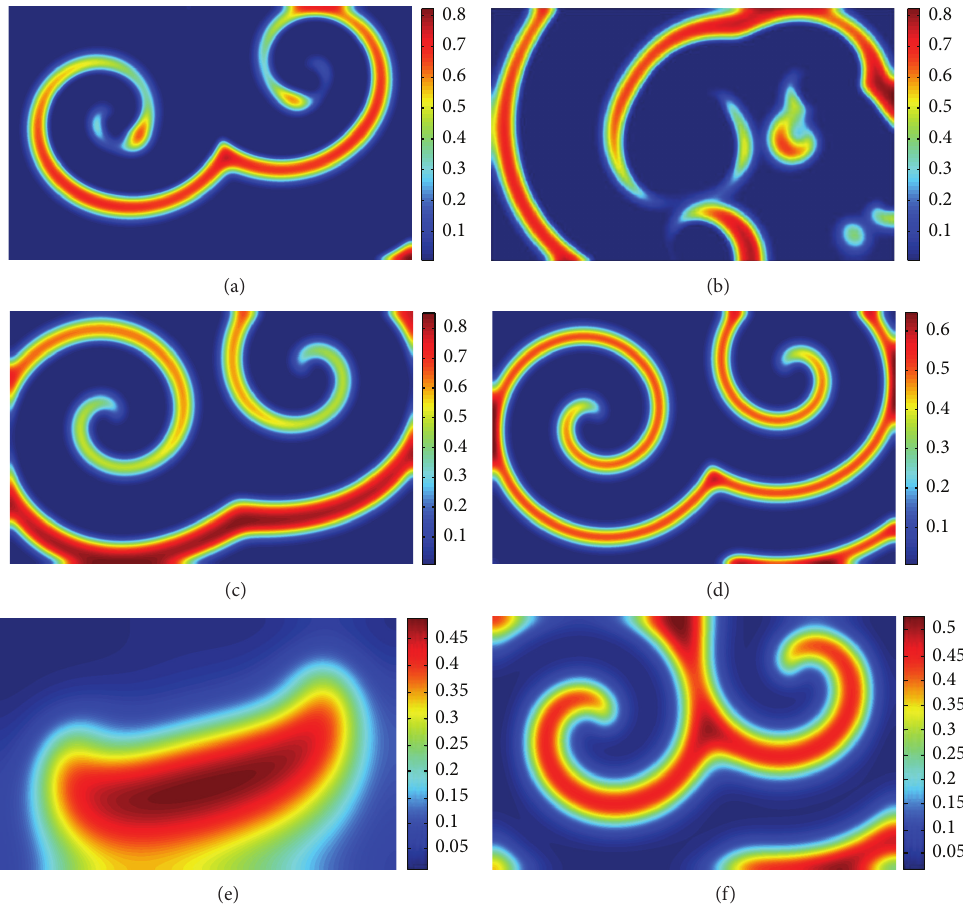
Figure 1: Spatiotemporal dynamics of model (3). In ((a), (b)) 𝑏 = 0.1 , ((c), (d)) 𝑏 = 0.2 , and ((e), (f)) 𝑏 = 0.5 . The iteration numbers are 140 in ((a), (c), (e)) and 3000 in ((b), (d),